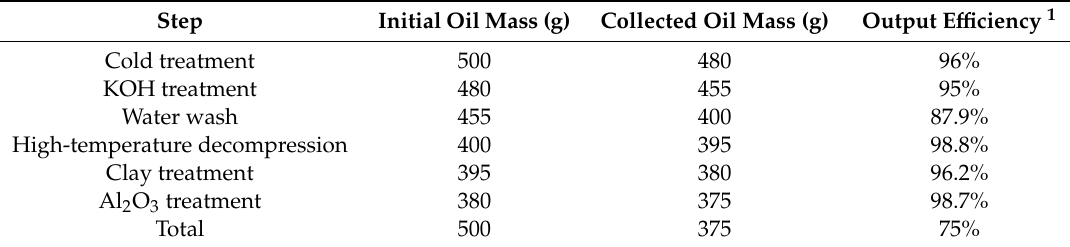
Table 1. Stepwise yield during the process of preparing vegetable insulating oil from Jatropha curcas seed oil.